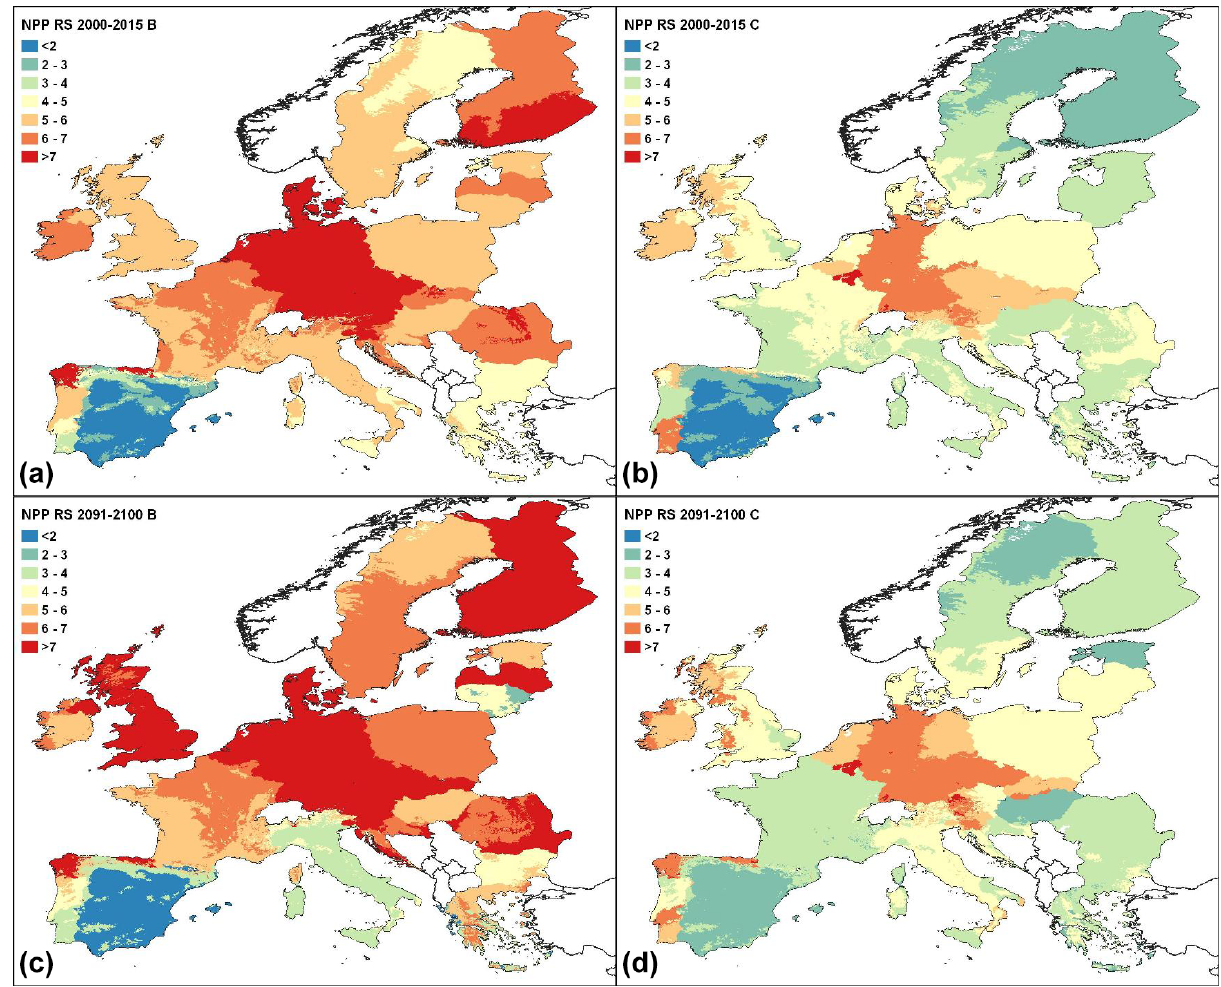
Figure 2. Geographical distribution of the average net primary production (NPP, in tCha − 1 yr − 1 ) estimated by CBM within the historical period 2000–2015 (a, b) and within the decade 2091–2100 (c, d) under the RS (i.e. excluding climate change). Broadleaved species are reported on the left side, and conifers are on the right